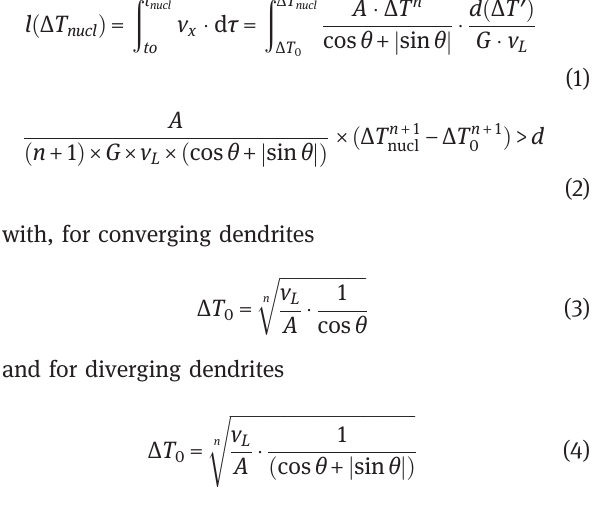
Table 3: SG sensitivity associated with combination effect for three forms of CMMCs, where P and N denote positive and negative,